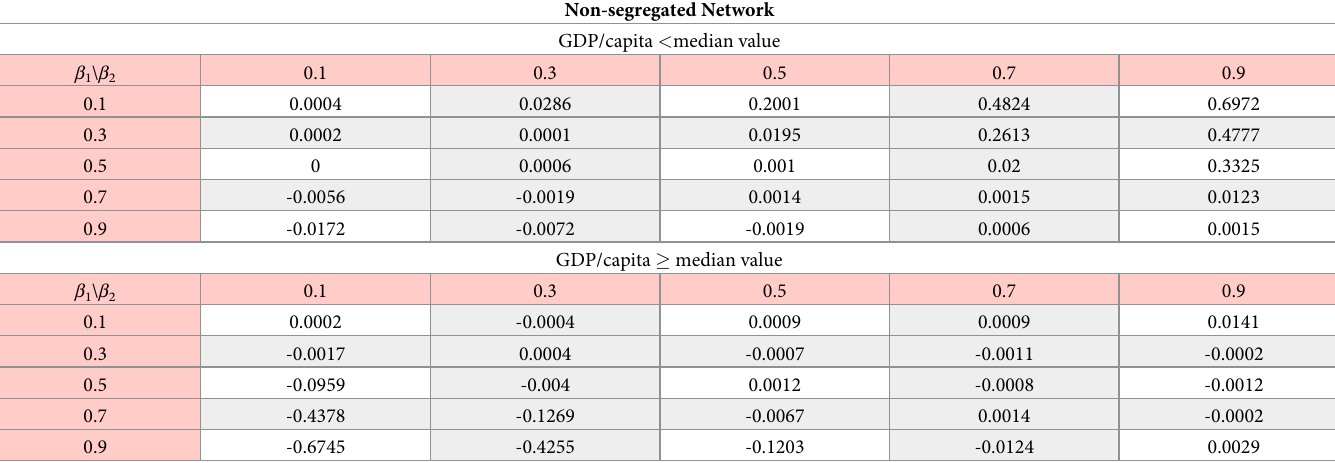
Table 2. This table documents the coefficients of linear regressions of numerical Δ s as a function of the Gini coefficient G , for the non-segregated network ( λ = 100). Please refer to the caption below Table 1 for further details. The reference value of the regression for empirical data is -0.0018 if GDP/capita < median value and -0.0017